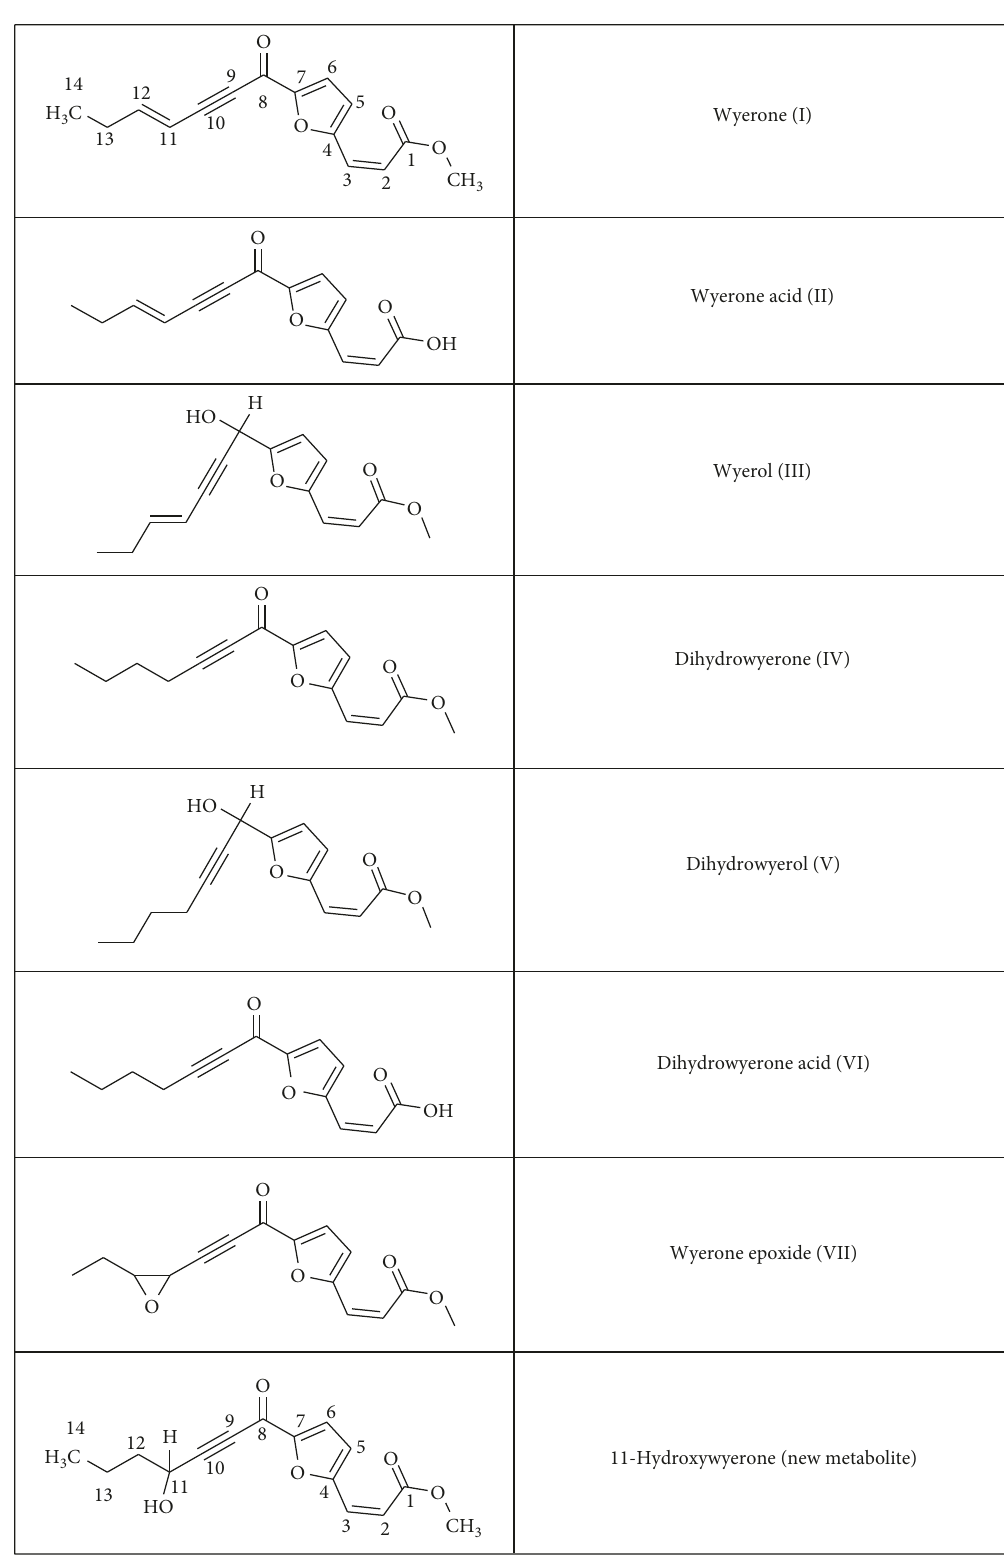
Figure 1: Structures of phytoalexins of Vicia faba (I, II, III, IV, V, VI, and VII) and the new metabolite Wyerone acid was observed to be the main phytoalexin in (Figure 1) [10–13]. The accumulation of wyerone and its leaves and pods, while wyerone was predominant in coty- derivatives in cotyledon, pod, and leaves of Vicia faba , in- ledons. The accumulation of wyerone and wyerone epoxide fected by Botrytis spp. fungi, were evaluated previously.